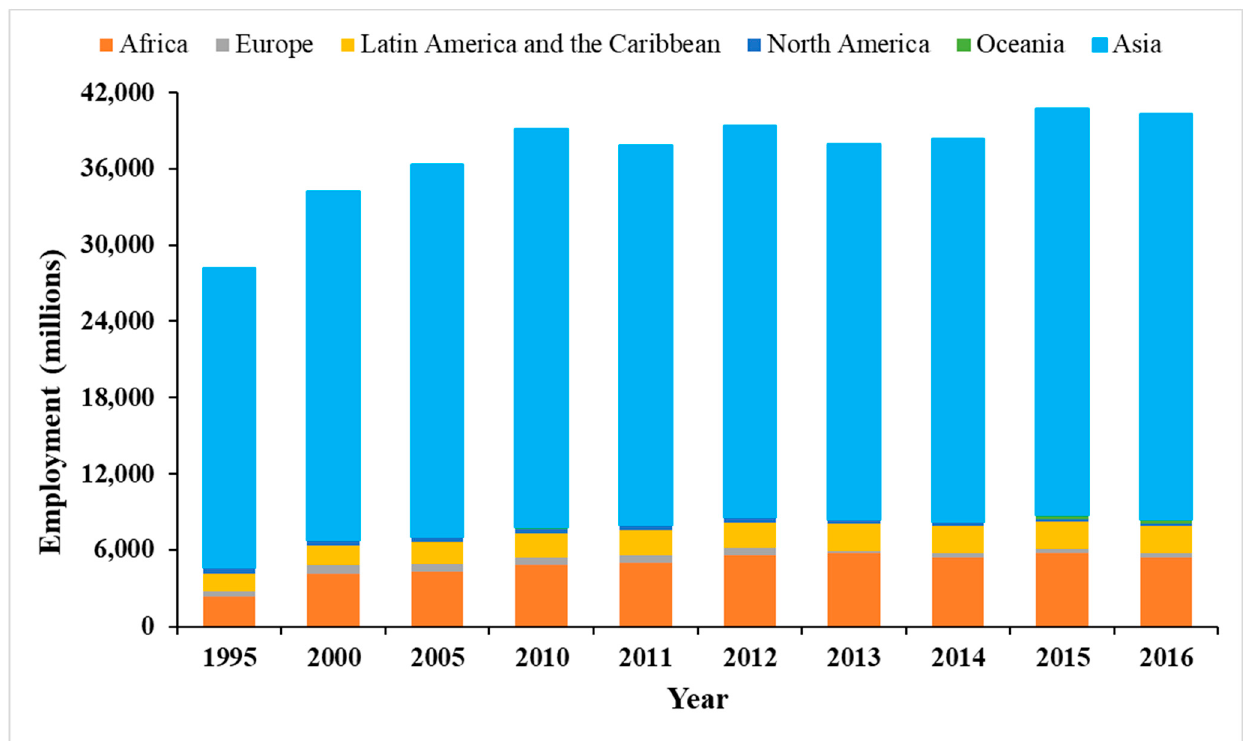
Figure 1. The global role of the fisheries sector for employment (Source: [3]). Fisheries have an important economic contribution worldwide. Fisheries products